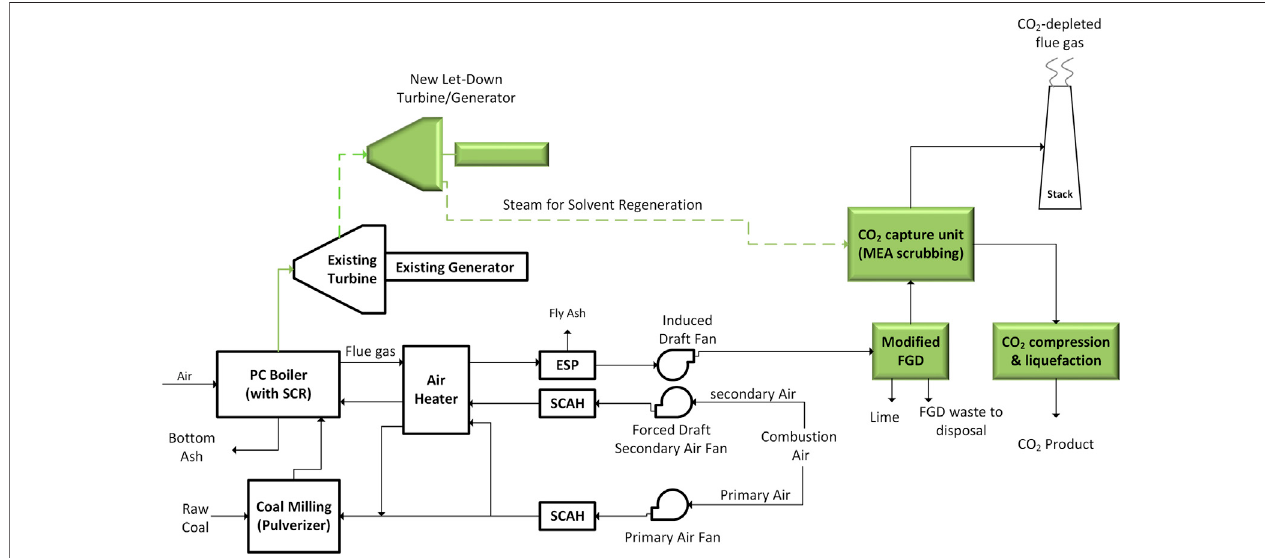
FIGURE 5 | Process fl ow diagram for a pulverized coal power plant retro fi tted with MEA absorption technology for CO 2 capture. Adapted from Ciferno (2007). Note: the new equipment is shown in green; ESP, Electro-Static Precipitator; SCAH, Steam Coil Air Heater; FGD, Flue Gas Desulfurization; and MEA,